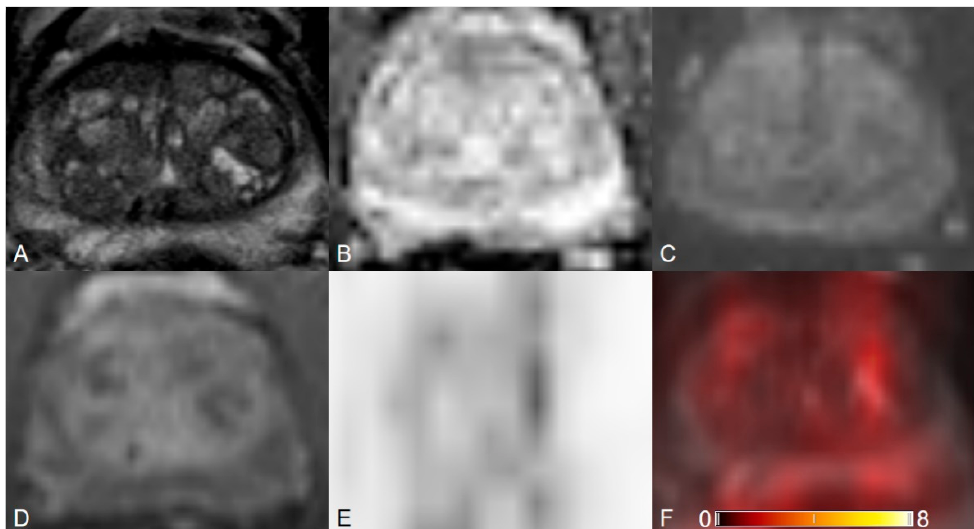
Figure 1. Transition zone with typical benign prostatic hyperplasia (BPH) changes. ( A ) Axial T2WI shows completely encapsulated “typical” nodules. ( B ) ADC map image presents no focal lesion with hypointense signal below the background. ( C ) DWI (b = 1000 s/mm 2 ) shows no lesion with a markedly hyperintense signal above the background. ( D ) Early dynamic contrast-enhanced image presents no positive enhancement within the typical BPH nodules. T2WI = 1, DWI = 1, DCE = negative, PI-RADS assessment category = 1. ( E ) PET image shows inhomogeneous [ 68 Ga]Ga-PSMA-11 uptake. ( F )[ 68 Ga]Ga-PSMA-11 PET/MRI fusion.